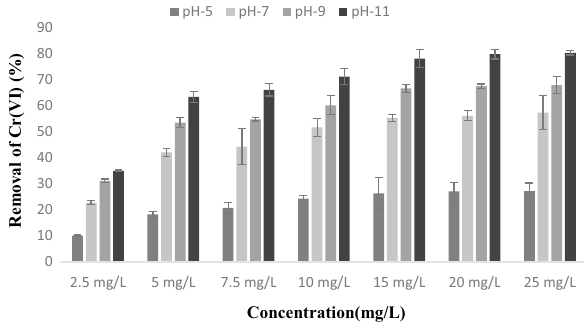
Fig. 5 Combined effect of initial concentration and pH on chromium